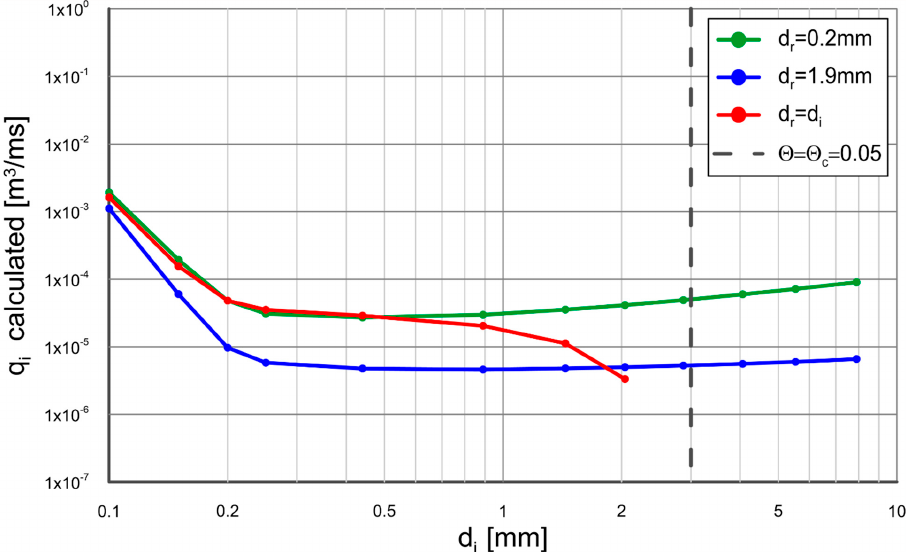
Figure 11. Exemplary result of calculations: the influence of fine fractions on transport of coarse fractions for 𝑢′ (cid:3033)∗ = 0.042 m/s .